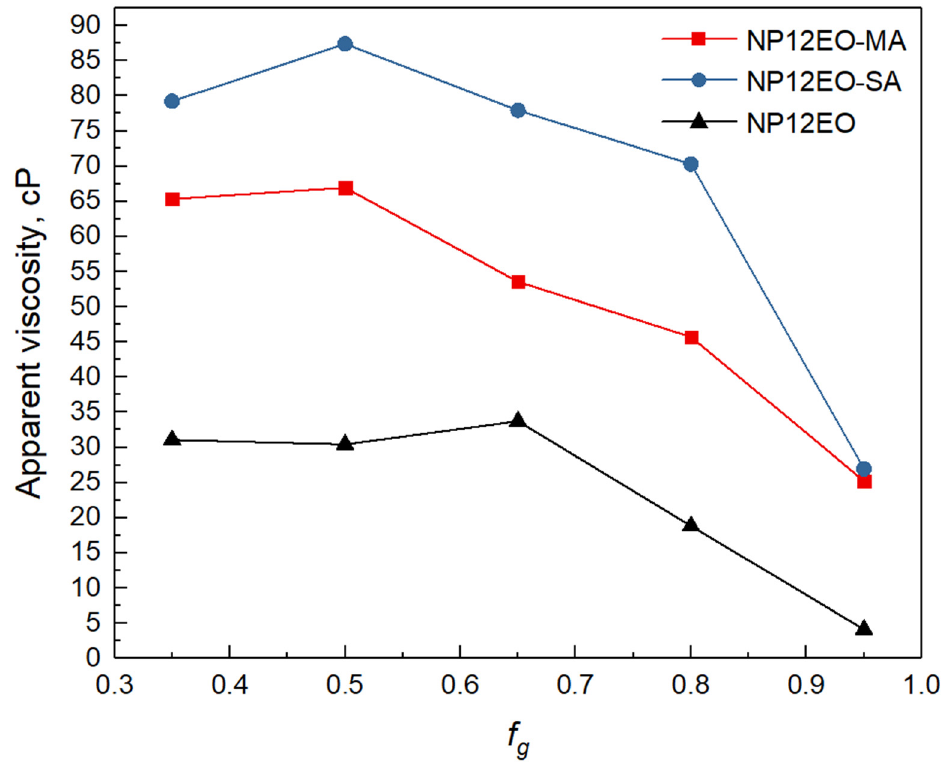
Figure 7. Foam quality scan results for surfactant solutions of 20% NaCl. Table 2. Apparent viscosity ( µ F app ) and pressure drop ( ∆ P ) values of foams at different foam quality ( f g